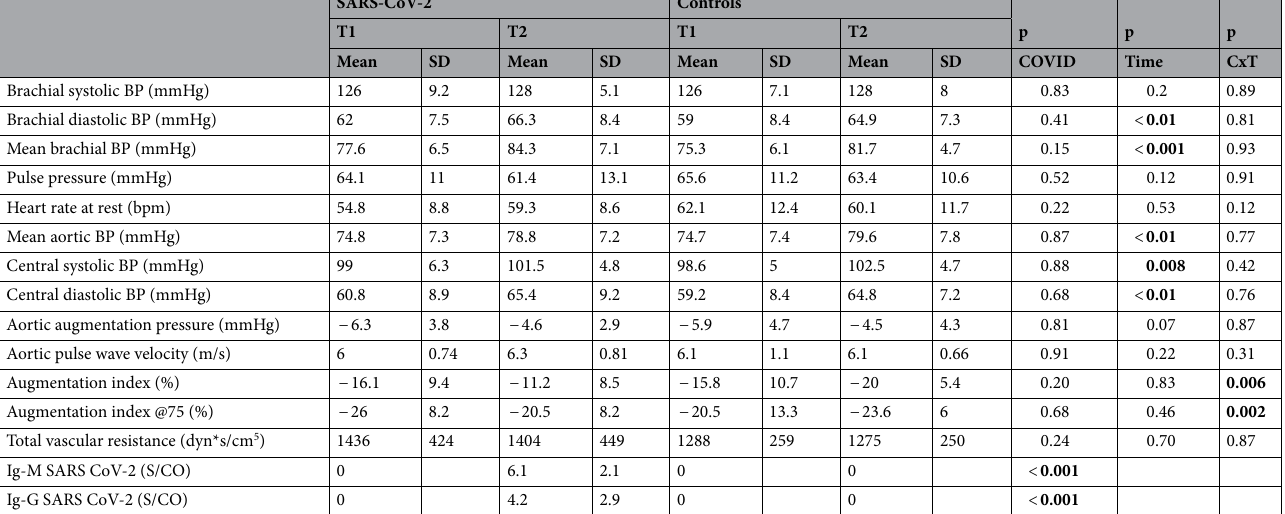
Table 2. Results of vascular evaluation showing differences between the baseline (T1) and follow-up examination (T2) in SARS-CoV-2 positive athletes (n = 15) and controls (n = 15). Bold values denote statistical significance at the p< 0.0125 level. C/T, COVID by time interaction effect; p values are for main effects (COVID and Time respectively) and for interaction effect; BP, Blood pressure; S/CO, Signal/cutoff